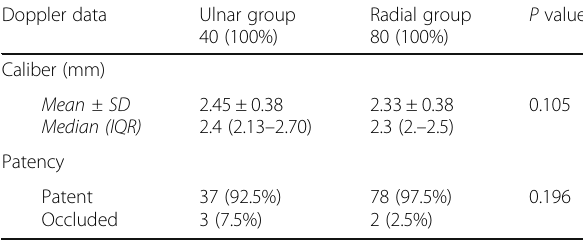
Table 5 Ultrasonographic data of the whole study